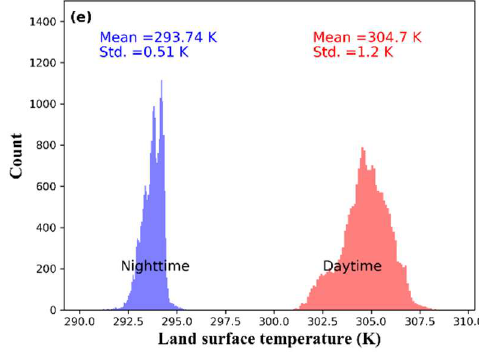
Figure 3. Histograms of the daytime and nighttime MASTs in each physiographical region. ( a ) High Himalaya, ( b ) High Mountains, ( c ) Middle Mountains, ( d ) Siwalik Hills, and ( e ) Terai Plain.